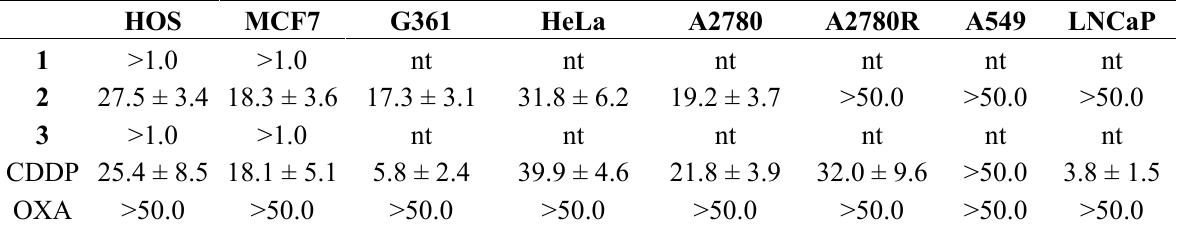
Table 1. The results of the in vitro antitumor activity of the studied platinum(II) oxalato complexes ( 1 – 3 ), cisplatin (CDDP) and oxaliplatin (OXA) against osteosarcoma (HOS), breast adenocarcinoma (MCF7), malignant melanoma (G361), cervix carcinoma (HeLa), ovarian carcinoma (A2780), cisplatin-resistant ovarian carcinoma (A2780R), lung carcinoma (A549) and prostate carcinoma (LNCaP) human cancer cell lines, as obtained by an MTT assay on the cells exposed to the compounds for 24